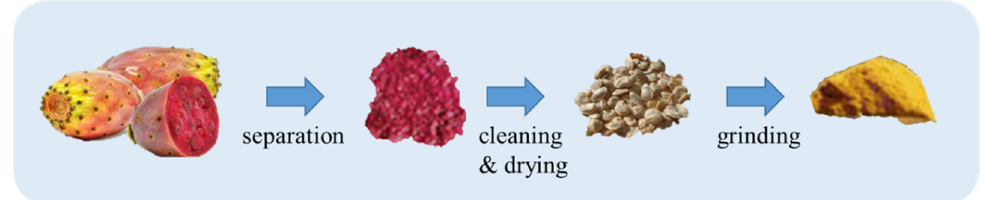
Figure 1. Preparation of prickly pear seeds for oil extraction [20,21].